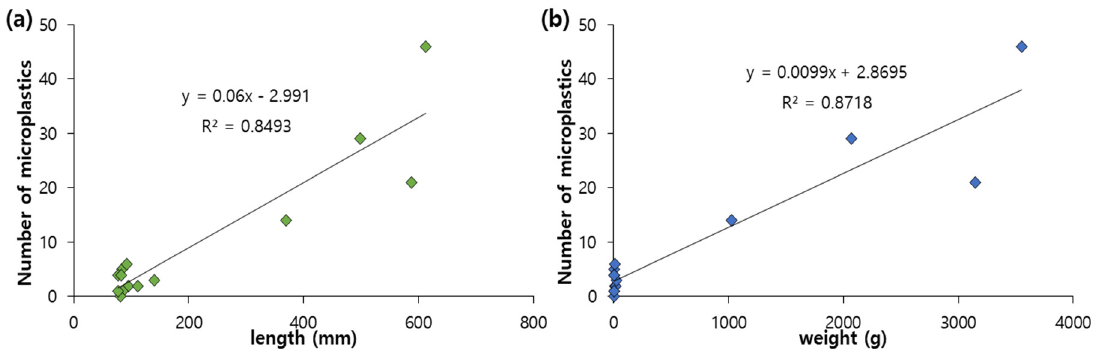
Figure 4. Correlation between microplastic concentration and ( a ) length and ( b ) body weight of fish samples (n = 14).